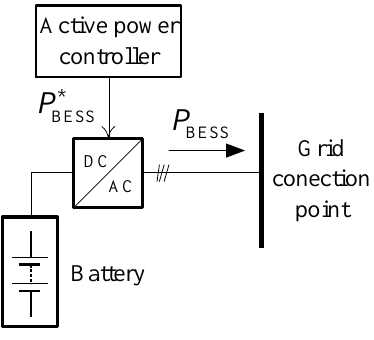
Figure 9. Basic components of the battery energy storage system (BESS).